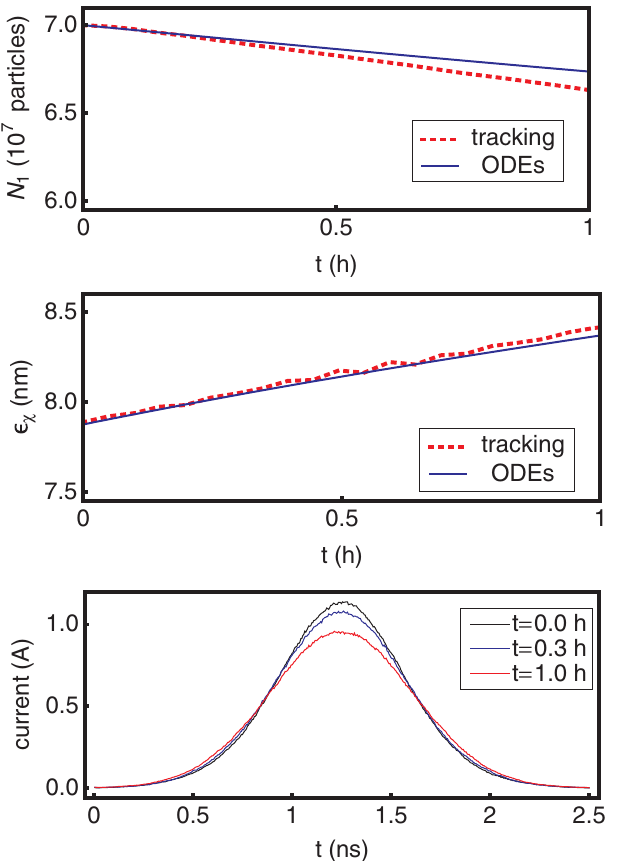
FIG. 10. (Color) The simulated time evolution in the LHC of the bunch intensity and transverse rms emittance during 1 h at the injection plateau without collisions. The bottom plot shows the longitudinal bunch profile at different times as simulated with tracking.